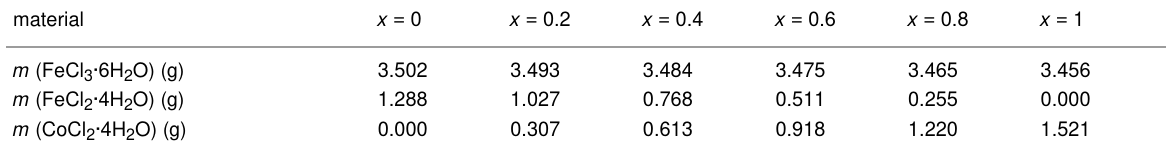
Table 5: Amounts of the starting materials to prepare 1.5 g of Co x Fe 3 − x O 4 nanoparticles.